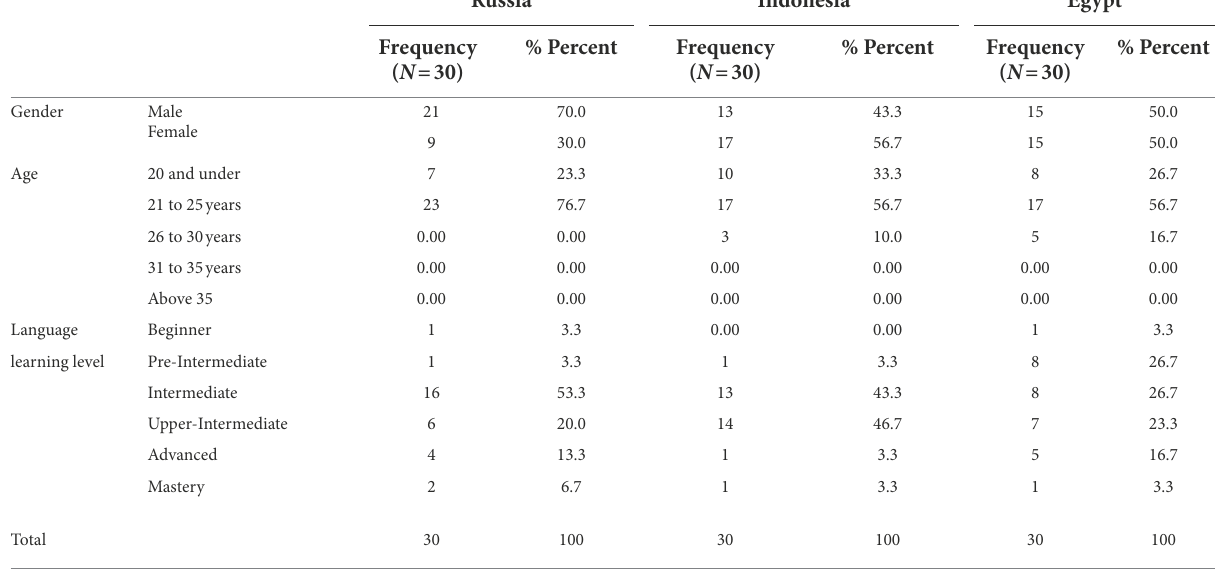
TABLE 1 Demographic stats of the